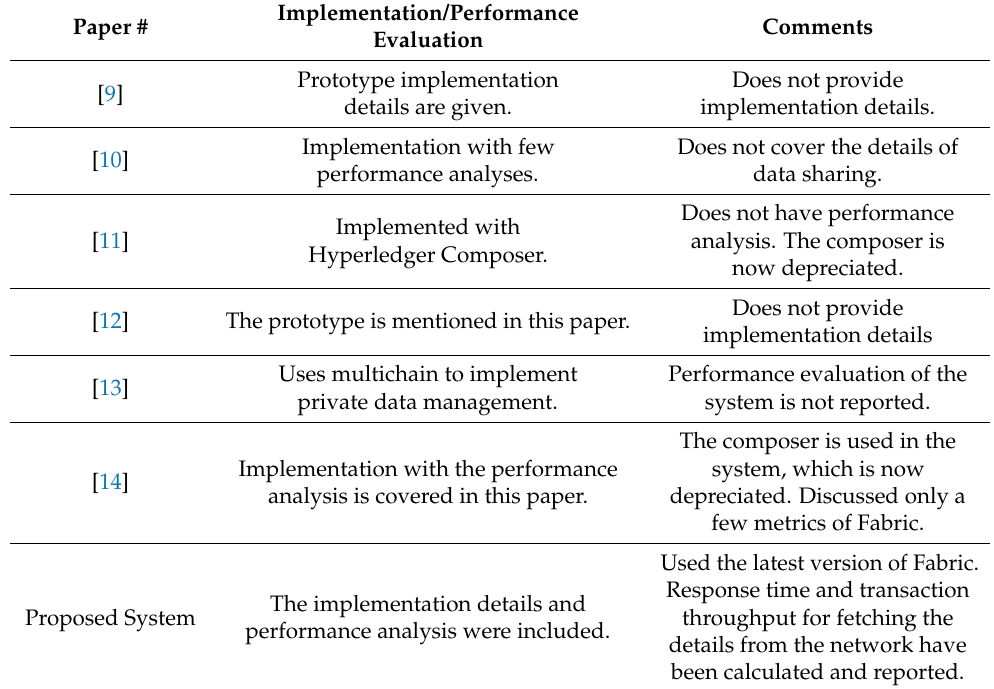
Table 4. Comparison between